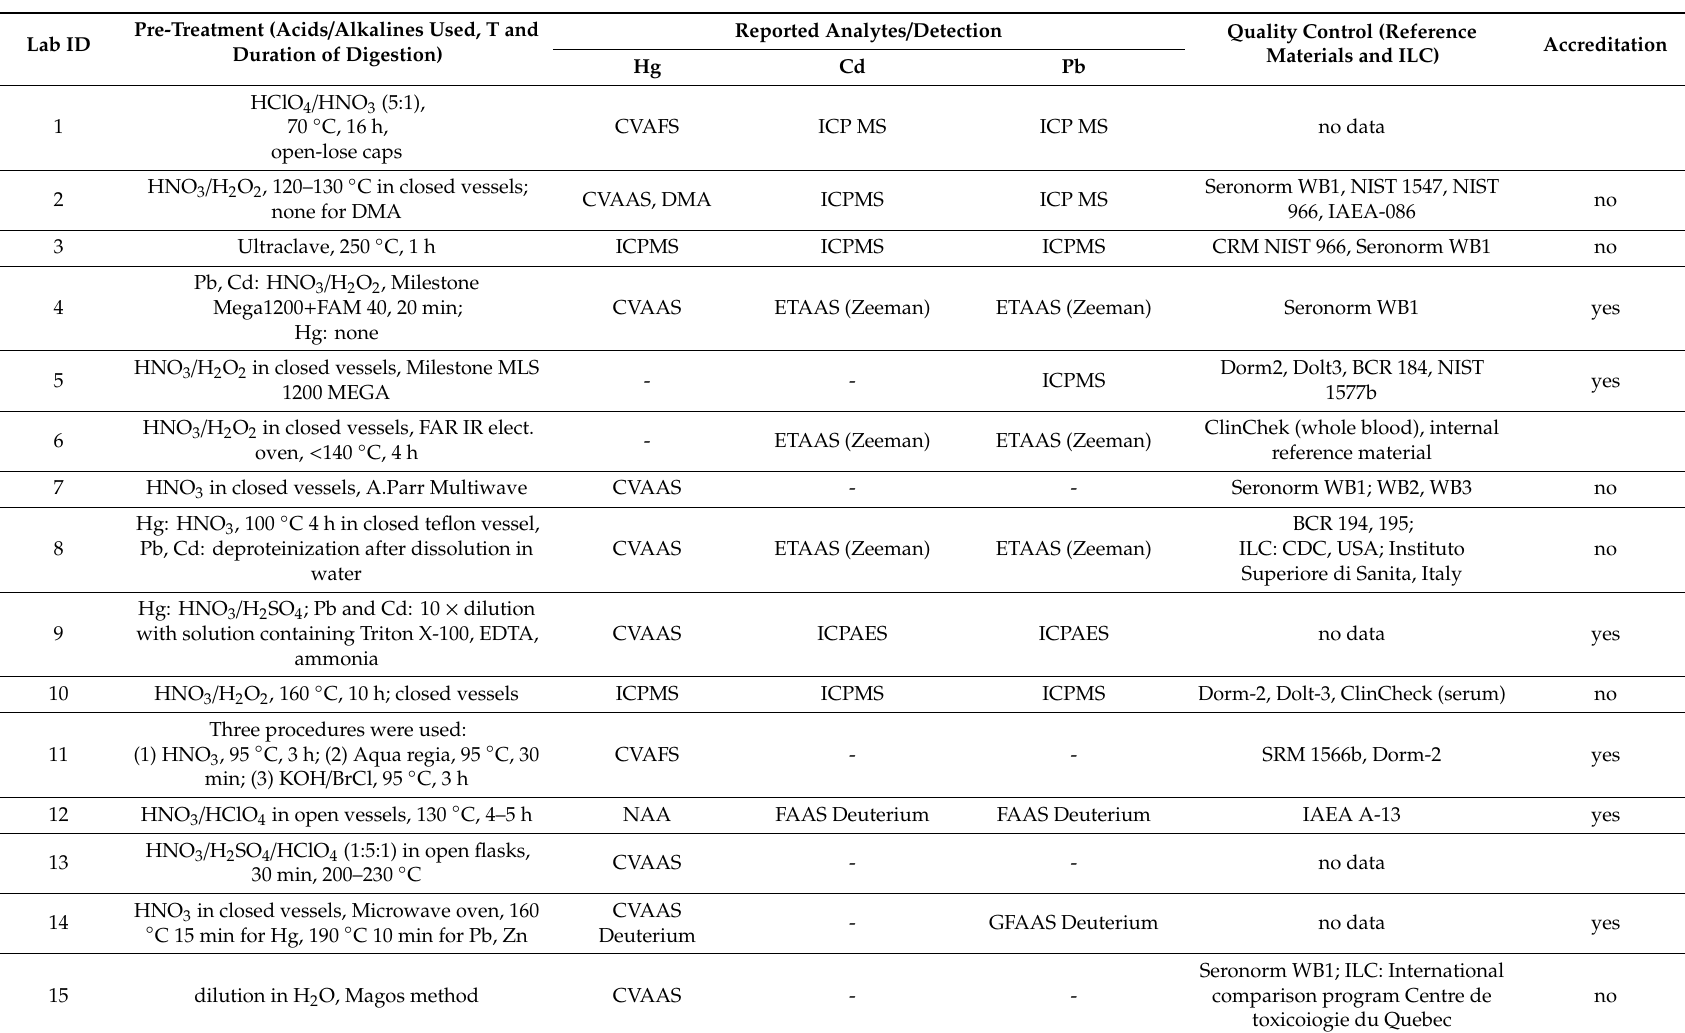
Table 1. List of sample pre-treatments and measurement methods used by the participating laboratories. ILC, inter-laboratory